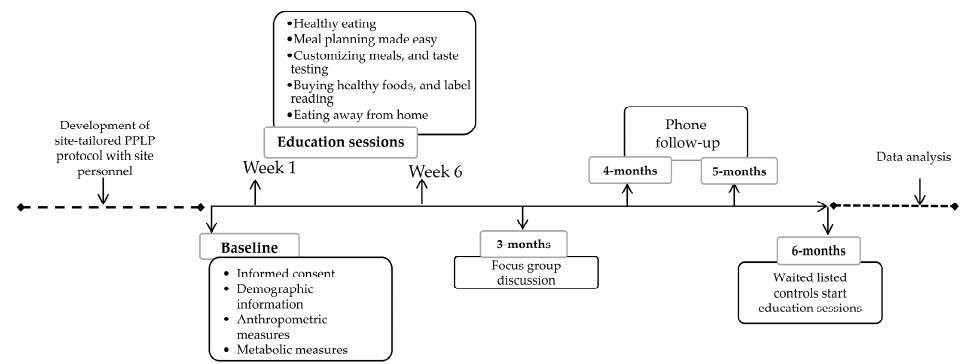
Figure 1. Intervention